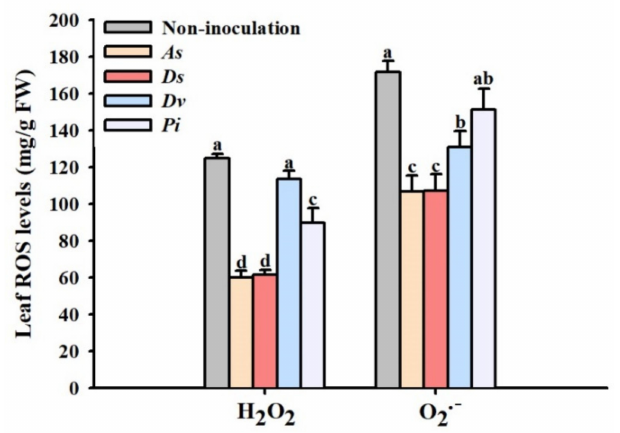
Figure 5. The effect of inoculation with Acaulospora scrobiculata ( As ), Diversispora spurca ( Ds ), D . versi- formis ( Dv ), and Piriformospora indica ( Pi ) on leaf superoxide radical (O 2 •− ) and hydrogen peroxide (H 2 O 2 ) concentrations of lane late navel orange trees. Data (means ± SD, n = 4) are significantly different ( p < 0.05) if followed by different letters above the